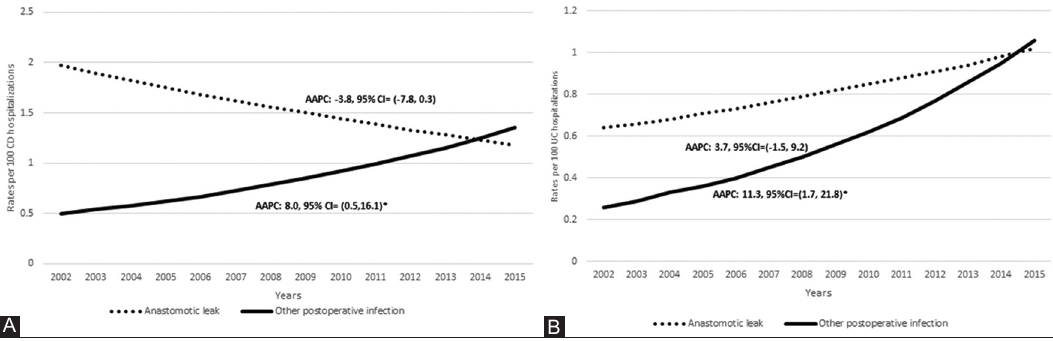
Supplemental Figure 4: Rates of post-operative complications per 100 Crohn’s disease [CD] (A) and ulcerative colitis [UC] (B) hospitalizations over the years 2002-2015 AAPC= Average Annual Percent Change.